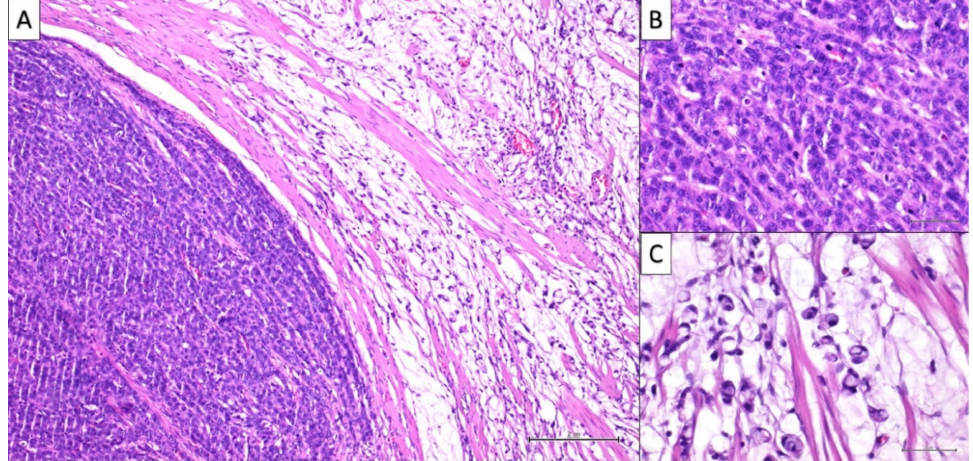
Figure 3. ( A ) Histologically, a carcinoma with a double component is observed: a neuroendocrine population (on the left side), and a poorly differentiated adenocarcinoma (on the right side) are clearly recognizable (H&E 10 × magnification). ( B ) A detail of the neuroendocrine component at higher magnification showing a neoplastic population with cord architecture, medium-sized elements with scant cytoplasm, atypical nuclei, and numerous mitotic figures (H&E 20 × magnification). ( C ) A detail of the adenocarcinomatous counterpart at higher magnification showing abundant mucus lakes with ‘floating’ scattered signet ring cells (H&E 20 ×